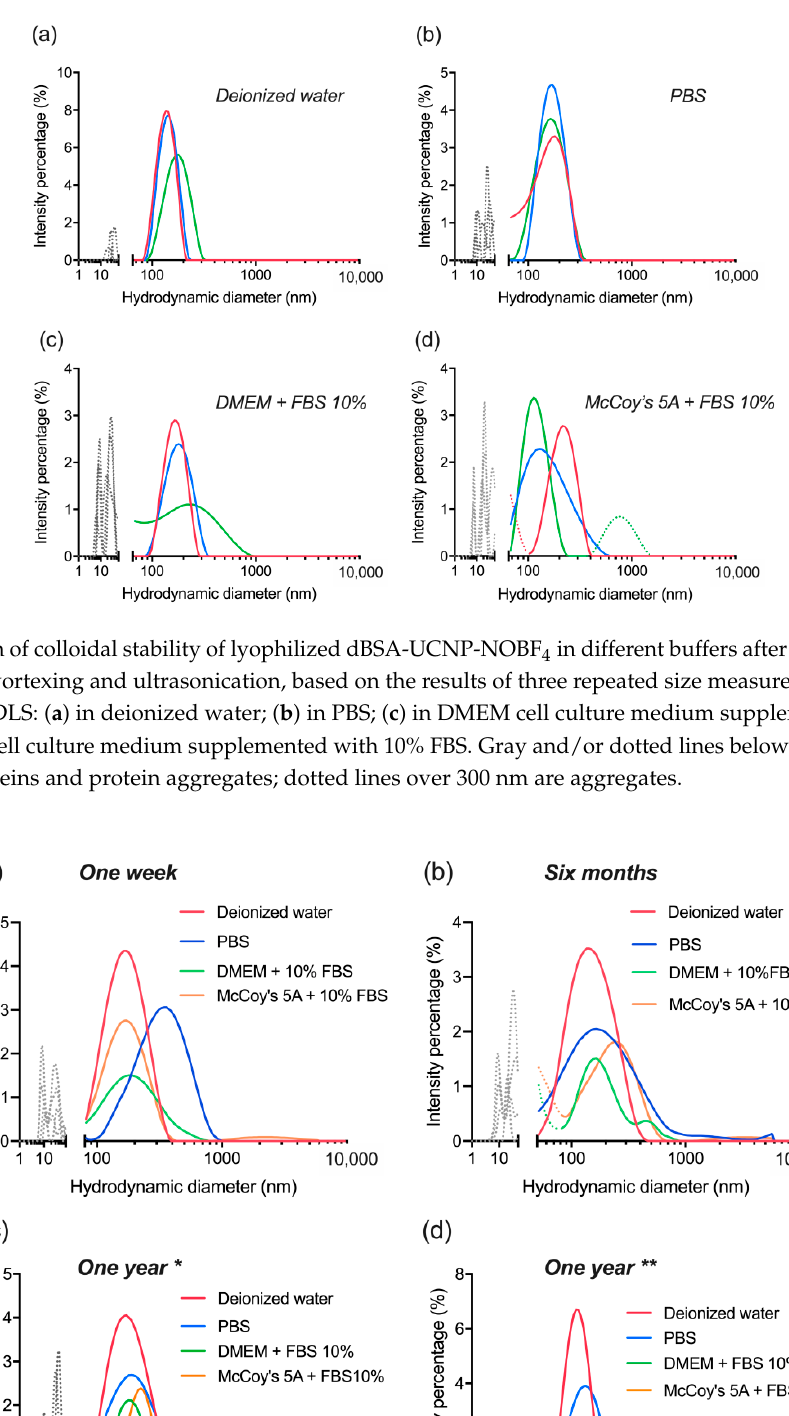
Figure 8. Evaluation of colloidal stability of lyophilized dBSA-UCNP-NOBF 4 in different buffers after one year of lyophilization and mixed by vortexing only, based on the results of three re- peated size measurements (shown in blue, red, and green) by DLS: ( a ) in deionized water; ( b ) in PBS; ( c ) in DMEM cell culture medium supplemented with 10% FBS; ( d ) in McCoy’s 5A cell cul- ture medium supplemented with 10% fetal bovine serum (FBS). Gray and/or dotted lines below 100 nm correspond to the presence of proteins and protein aggregates; dotted lines over 300 nm are aggregates.